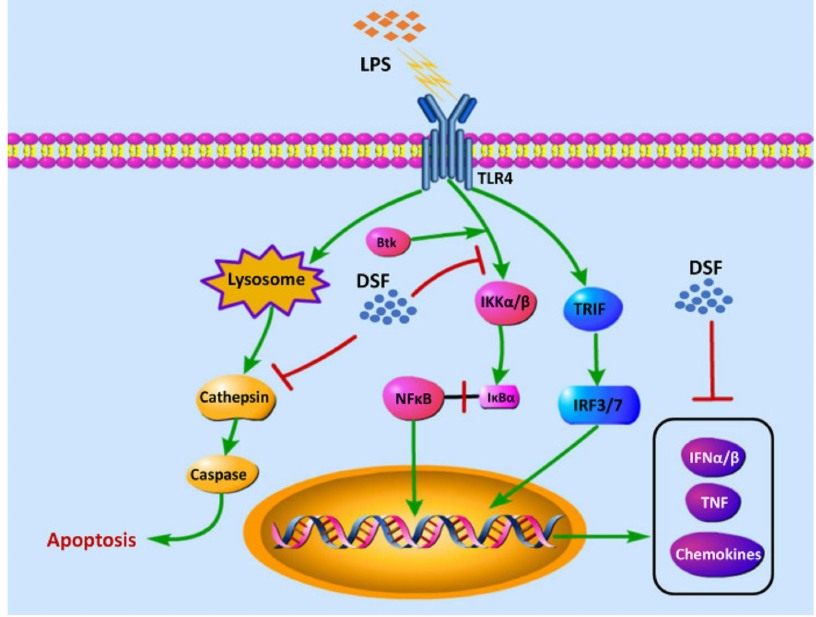
Figure 8. The hypothesis of the molecular mechanism of DSF in the anti-inflammatory